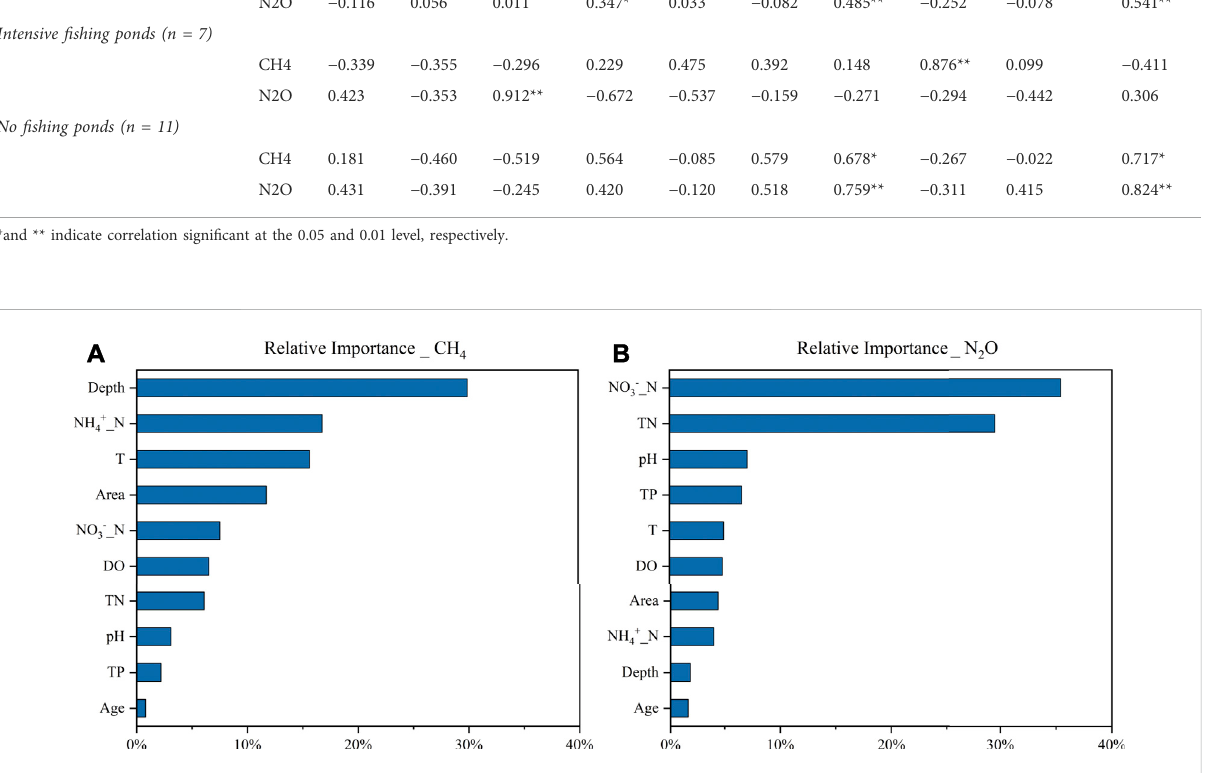
FIGURE 5 Relative importance of the environmental variables for CH 4 (A) and N 2 O (B) calculated by Multiple Linear